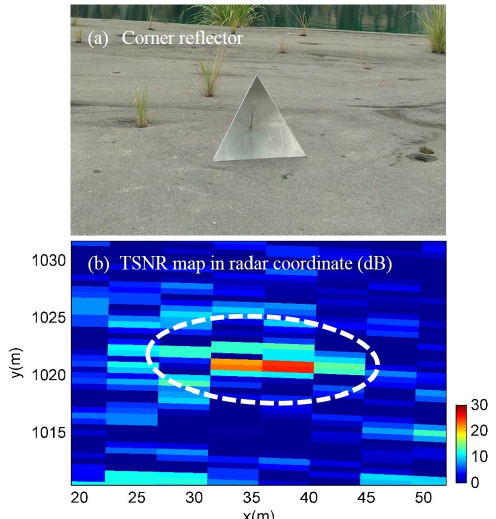
Figure 3. Corner reflector and its GB-SAR image